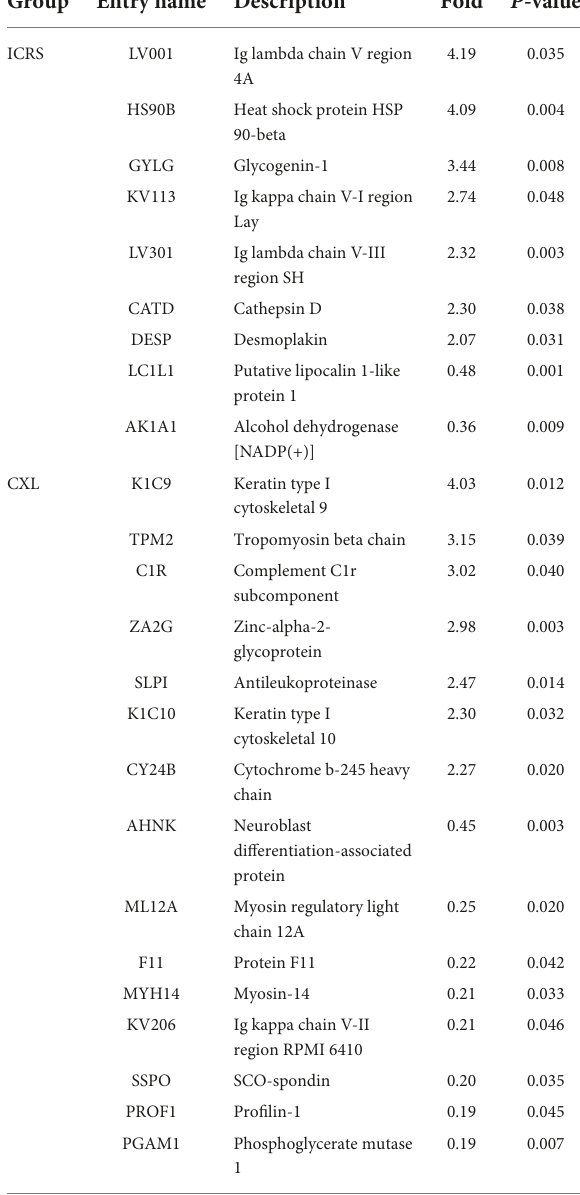
TABLE 3 Proteins with the most relevant expression changes before and after the intervention by surgery type.